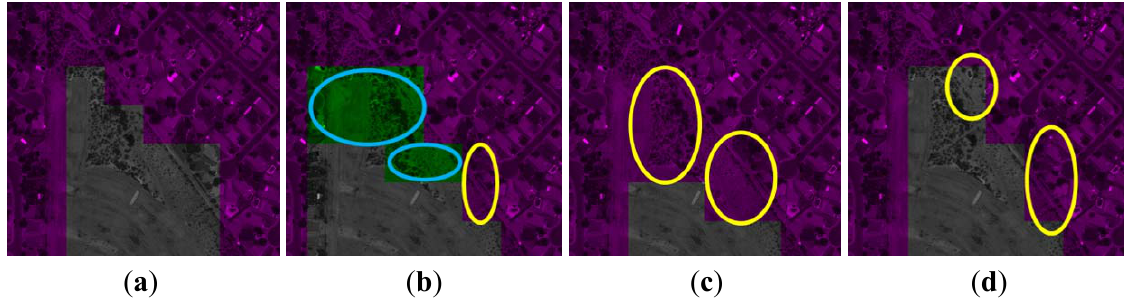
Figure 9. Partial enlarged view of different annotation results. ( a ) Ground